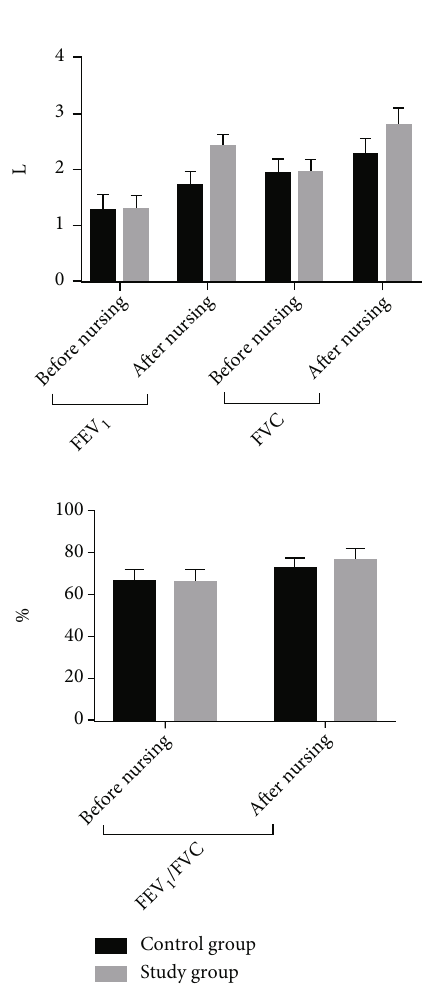
Figure 1: Histogram comparing pulmonary function before and after patient care in the two